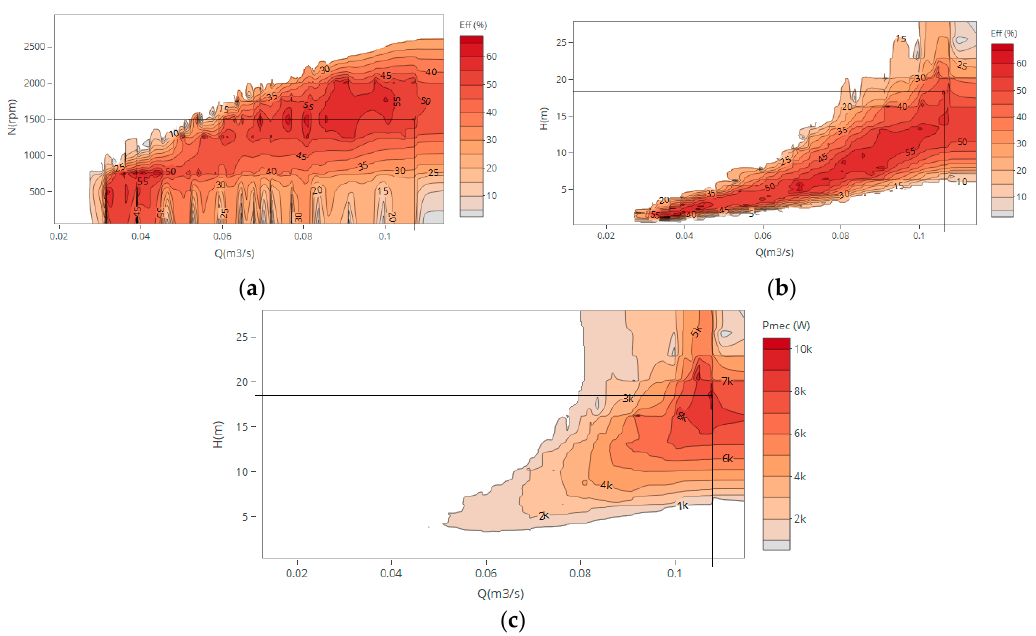
Figure 9. Hill charts obtained from new proposed affinity laws for discharges between 50 and 155 L/s: ( a ) Efficiency vs. flow and rotational speed; ( b ) Efficiency vs. flow and head; ( c ) Mechanical vs. flow and head.